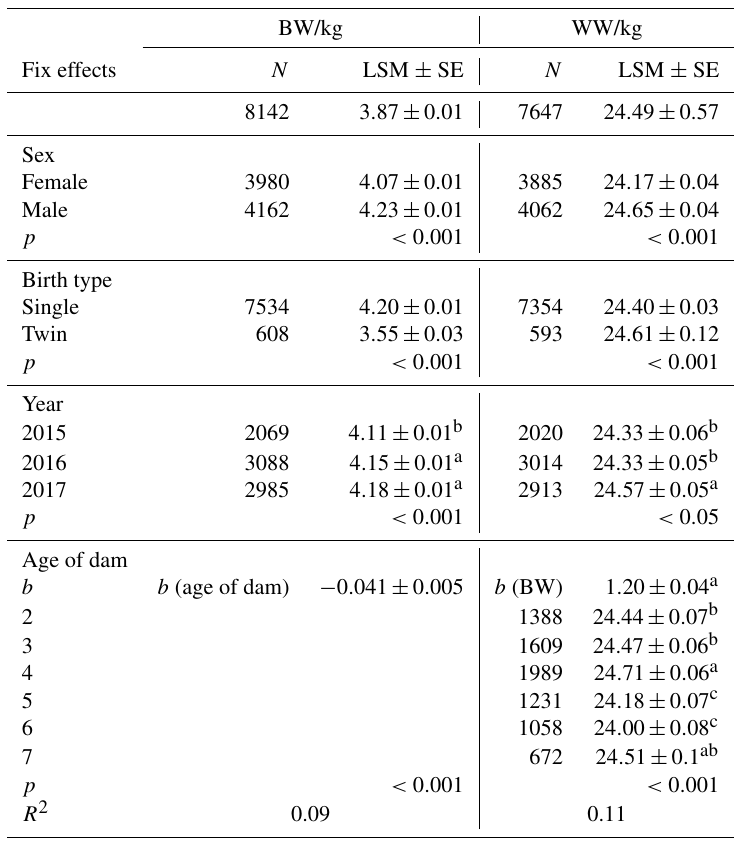
Table 2. The least-squares means (LSMs) and standard errors (SEs) of sex, birth type, year, and age of dam effects for Awassi lambs’ BW and WW. BW/kg WW/kg Fix